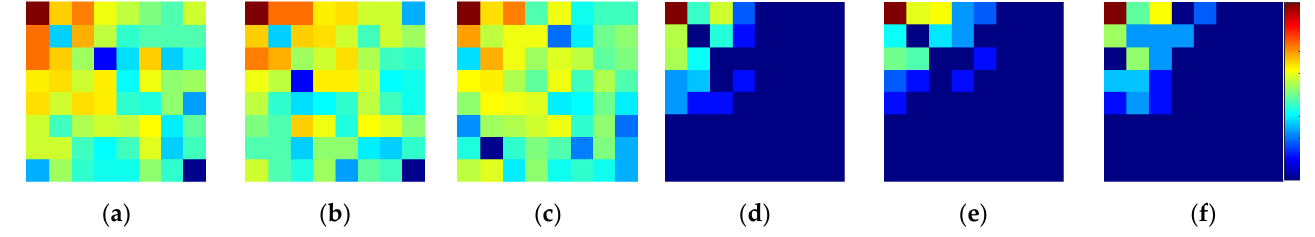
Figure 5. The DCT transform of the original and scrambled images. ( a – c ) DCT coefficients and ( d – f ) their quantized representations with 𝑄 𝑓 = 80 . ( a ) Original image. ( b ) Conventional EtC image.